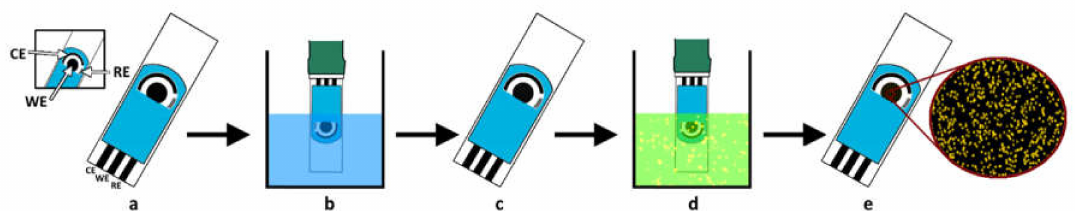
Figure 1. Preparation of screen-printed electrode modified with gold nanoparticles (SPE-AuNps): ( a ) bare SPE (CE = counter electrode, WE = working electrode and RE = reference electrode tequilas), ( b ) electrochemical pretreatment, ( c ) activated SPE, ( d ) electrodeposition of 1 mM HAuCl 4 and ( e )